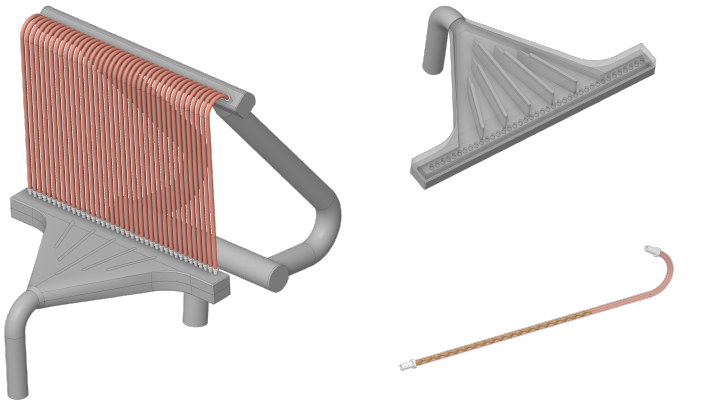
Figure 3. CAD model of the OVT mock-up ( left ), diffuser ( top right ), PFU channel ( bottom right ).